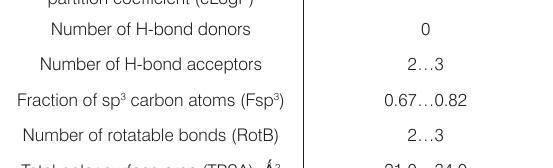
Table 2. (cid:51)(cid:75)(cid:92)(cid:86)(cid:76)(cid:70)(cid:82)(cid:70)(cid:75)(cid:72)(cid:80)(cid:76)(cid:70)(cid:68)(cid:79)(cid:3)(cid:83)(cid:68)(cid:85)(cid:68)(cid:80)(cid:72)(cid:87)(cid:72)(cid:85)(cid:86)(cid:3)(cid:82)(cid:73)(cid:3) N -methyl derivatives of the amines 6 – 11 . Parameter Value range Molecular weight (MW)